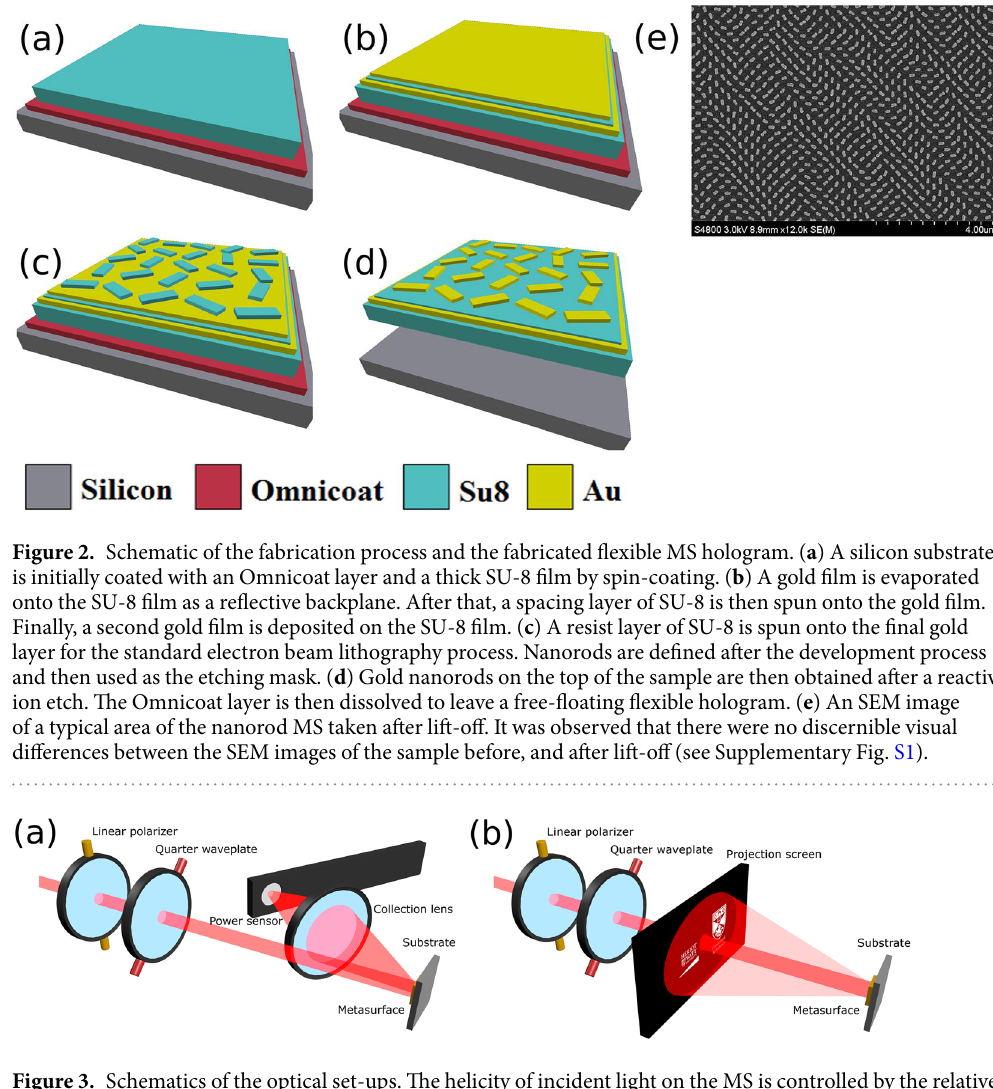
Figure 3. Schematics of the optical set-ups. The helicity of incident light on the MS is controlled by the relative angle between the linear polarizer and the quarter waveplate. In these images right handed circularly polarized light is shown. ( a ) To make efficiency measurements the light scattered by the MS is collected by a f = 25.4 mm lens and the intensity is measured with a Thorlabs S130C Photodiode Power Sensor ( b ) To photograph the holographic image the light scattered from the MS is projected onto a